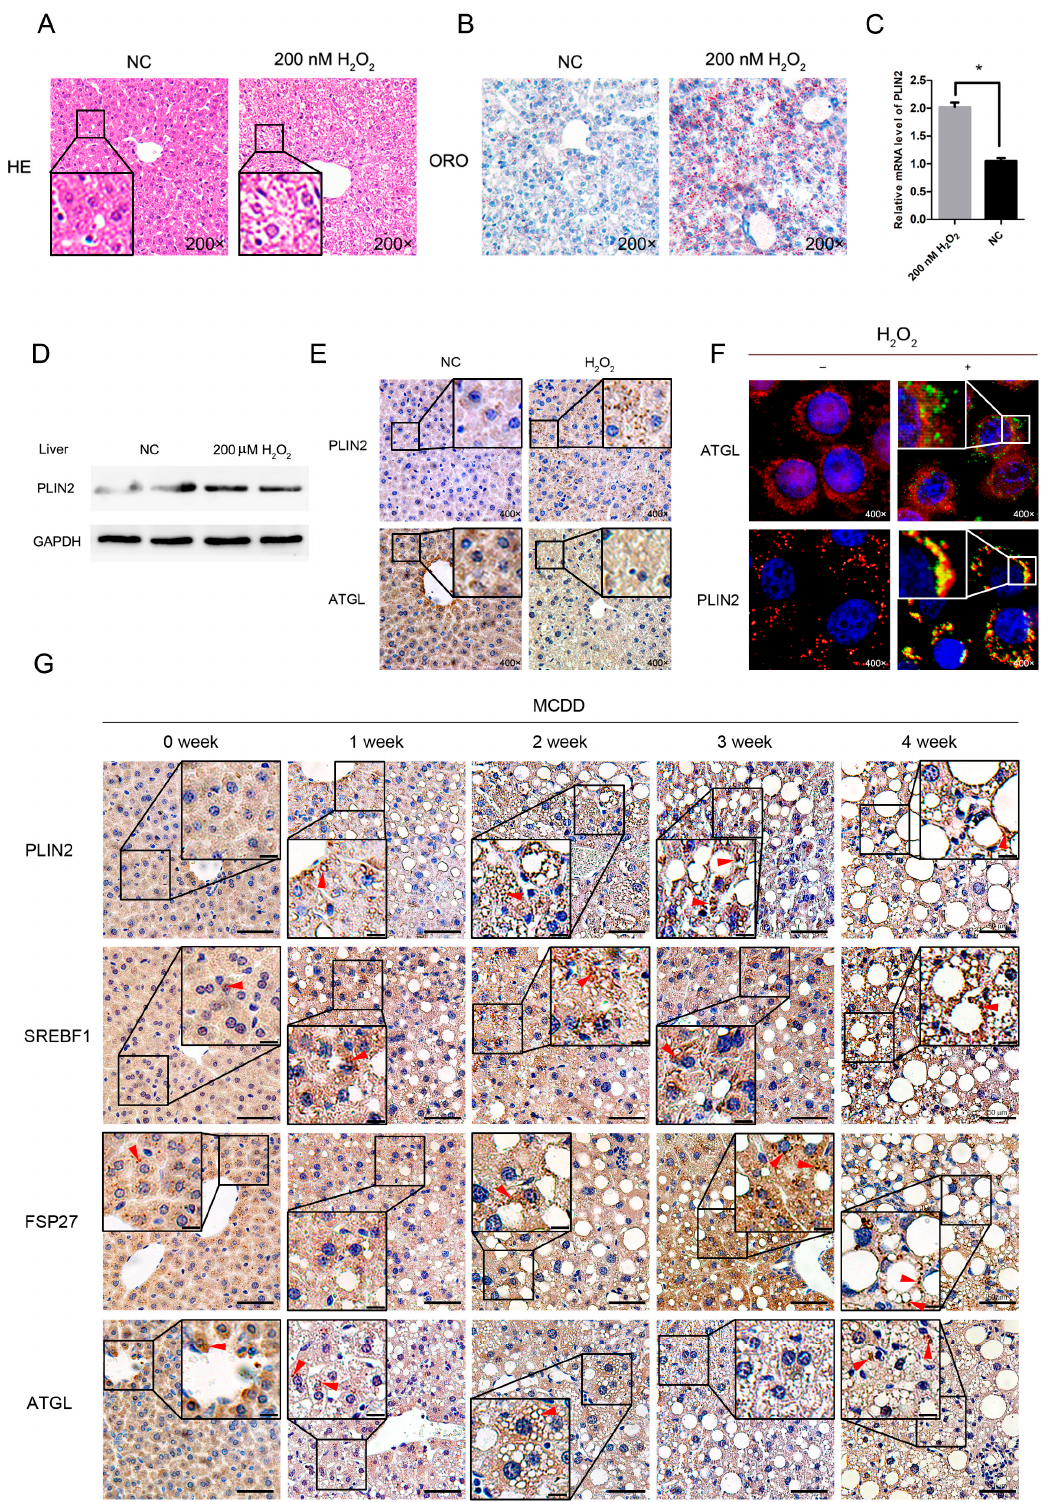
Figure 5. Following treatment with hydrogen peroxide, the expression level of PLIN2 in the liver tissue and the lipid content increased. Liver tissue morphology and lipid content were measured after intraperitoneal injection of 200 μ M hydrogen peroxide for 24 h. ( A ) HE slices detection. ( B ) Oil Red O